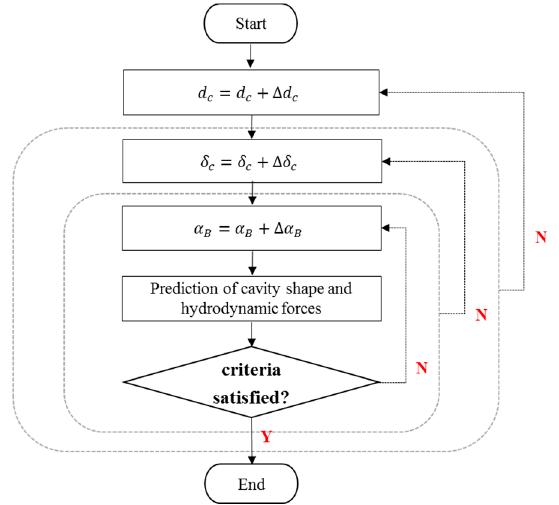
Figure 4. Flowchart for determining the conditions of straight level